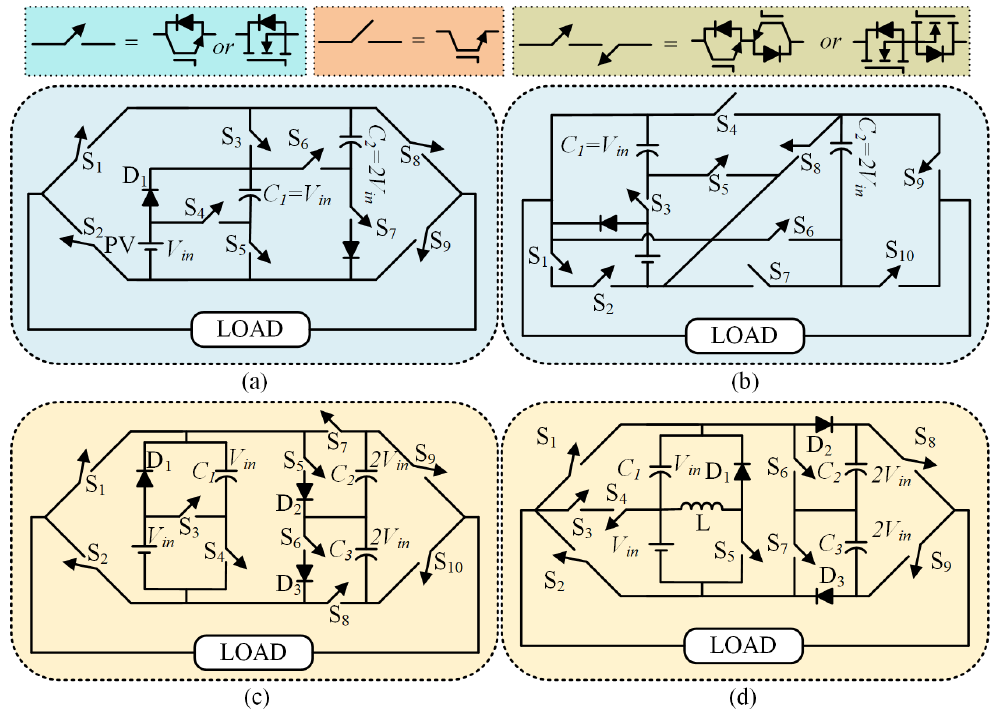
Figure 1. Existing nine-level inverter ( a ) [8], ( b ), [16], ( c ) [1], ( d ) Proposed extended structure. The performance of SCMLI is compared to the other parameters that affect it. Using switched capacitors, a unique QBI single-phase nine-level inverter is suggested in